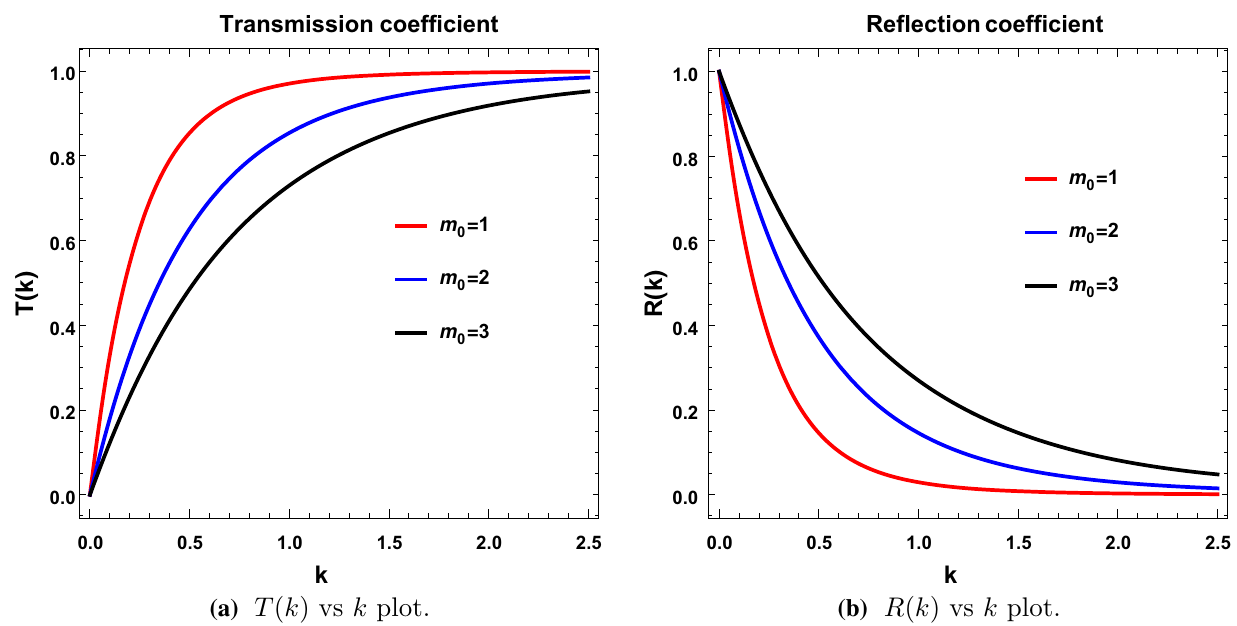
Fig. 16 Wave number dependence of Bogoliubov coefficients for mass profile II is shown here